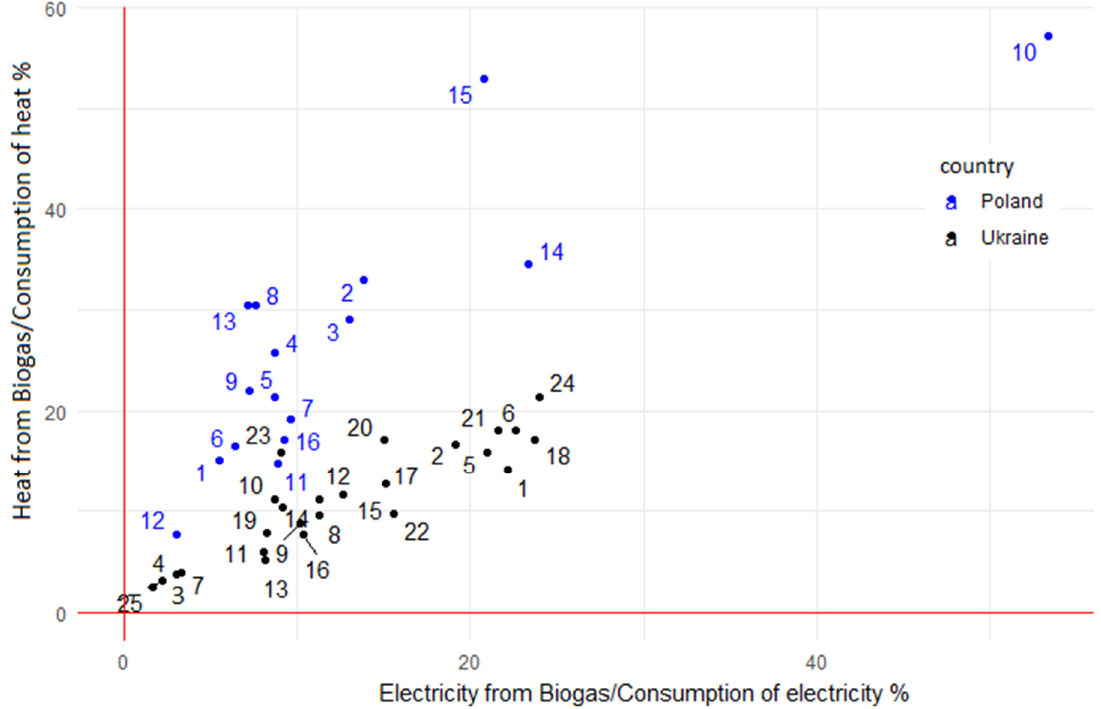
Figure 4. Meeting the demand for electricity and heat with the use of the “basic” potential of biogas production. Source: Own study.